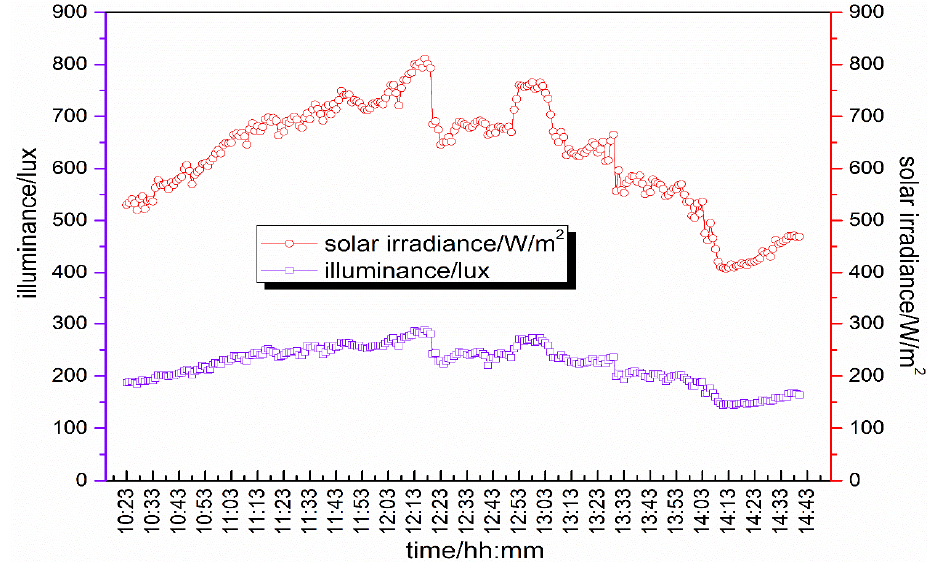
Figure 14. A diagram of the system’s output illuminance compared to solar radiation intensity (medium intensity).